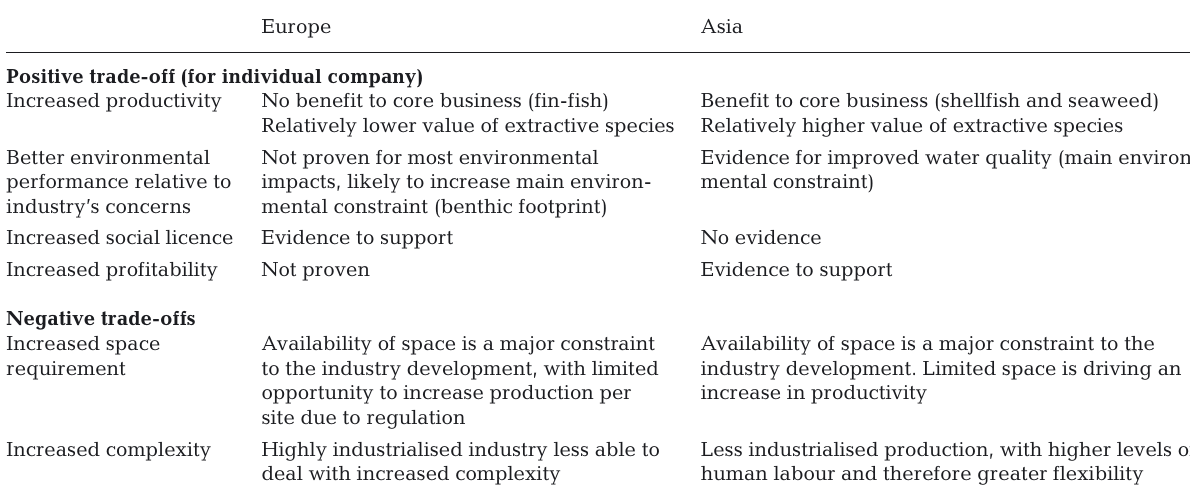
Table 1. The relative balance of trade-offs associated with IMTA in Europe and